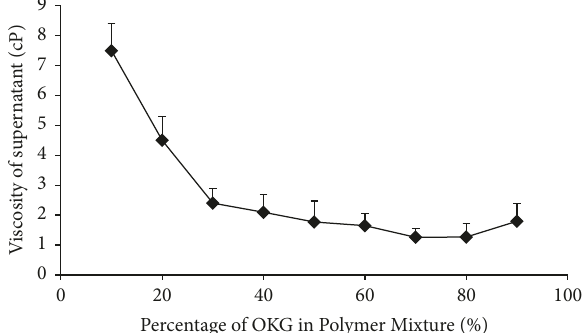
Figure 2: Effect of increasing the percentage of OKG in polymer mixture on viscosity of